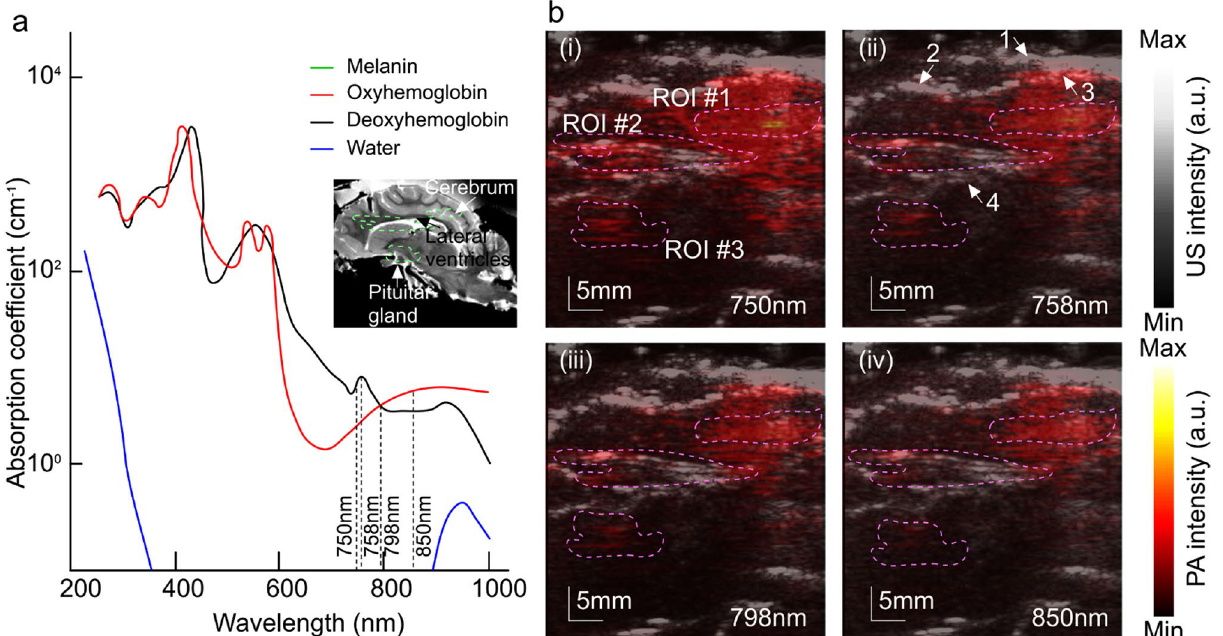
Figure 2. Absorption coefficient spectra of endogenous tissue chromophores and reconstructed PA images overlaid on ultrasound image. ( a ) HbO 2 and HbR, 150 g/L in blood; water, 80% by volume in tissue; lipid. Figure adapted with from 31 . In the inset, an MRI cross-sectional (sagittal plane) of ex-vivo sheep brain depicting major anatomical structure and relative ROI locations 32 ( b ) ROIs considered for estimating sO 2 from reconstructed PA images overlaid on US imaging plane at (i) 750 nm, (ii) 758 nm, (iii) 798 nm, (iv) 850 nm. Anatomical structures annotated in (ii) 1: skull, 2: fibrous tissue growth within the cranial window, 3: superficial